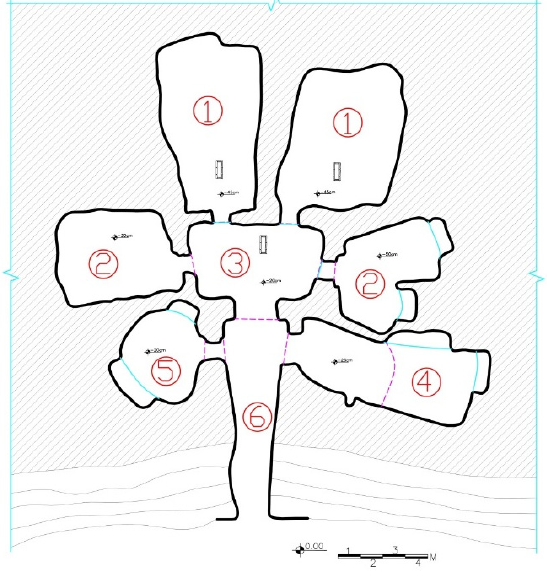
Figure 22. The fourth-stage fulfillment of excavation of rooms in cross − section and plan view.